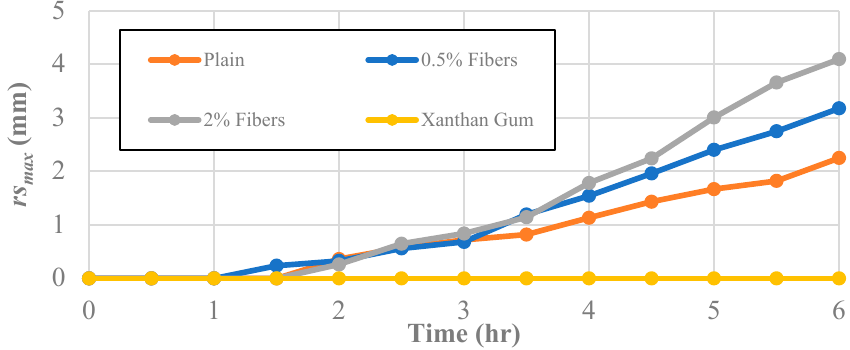
Figure 9. The effect of different additives on the maximum radial shrinkage, rs max .